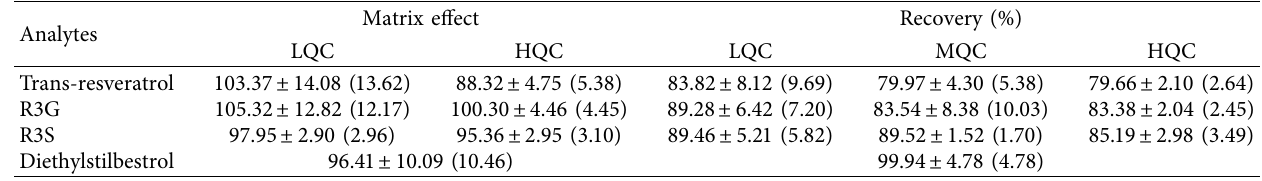
Table 3: Matrix effect and recovery of trans-resveratrol, R3G, R3S, and diethylstilbestrol (IS). Matrix Analytes